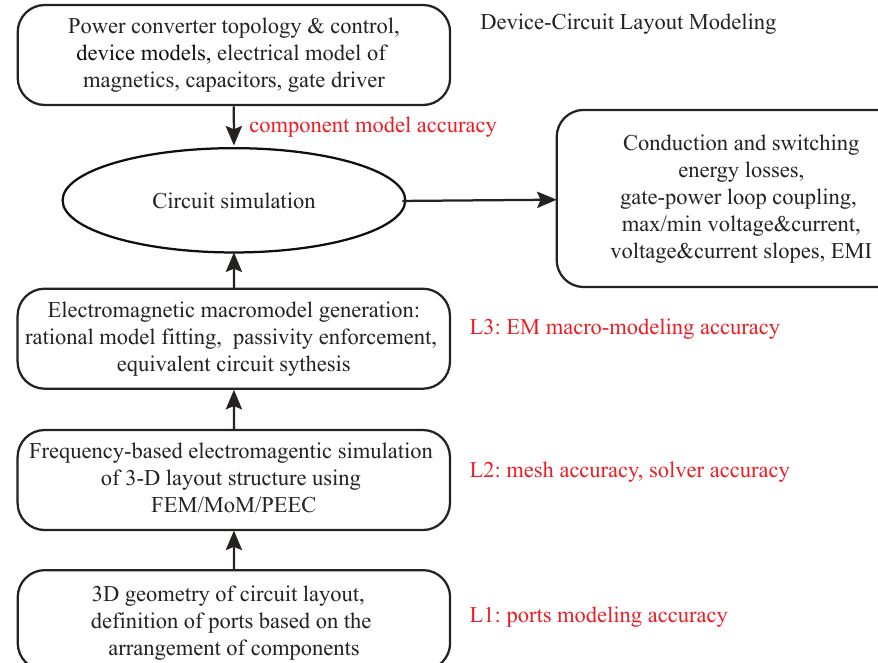
Figure 1. Diagram showing the state-of-the-art device-circuit layout